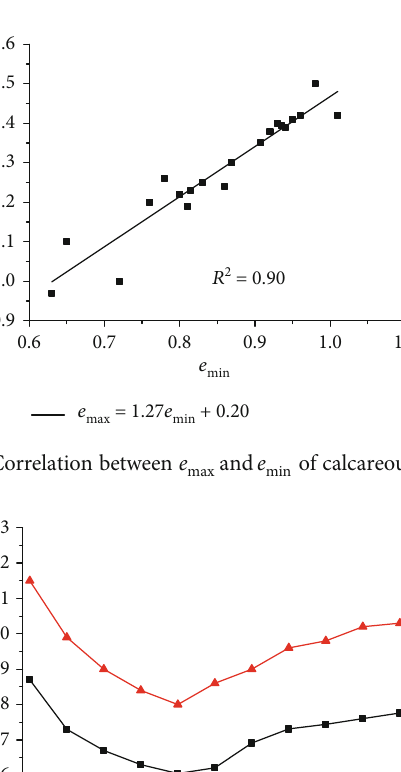
Figure 10: Variation in e